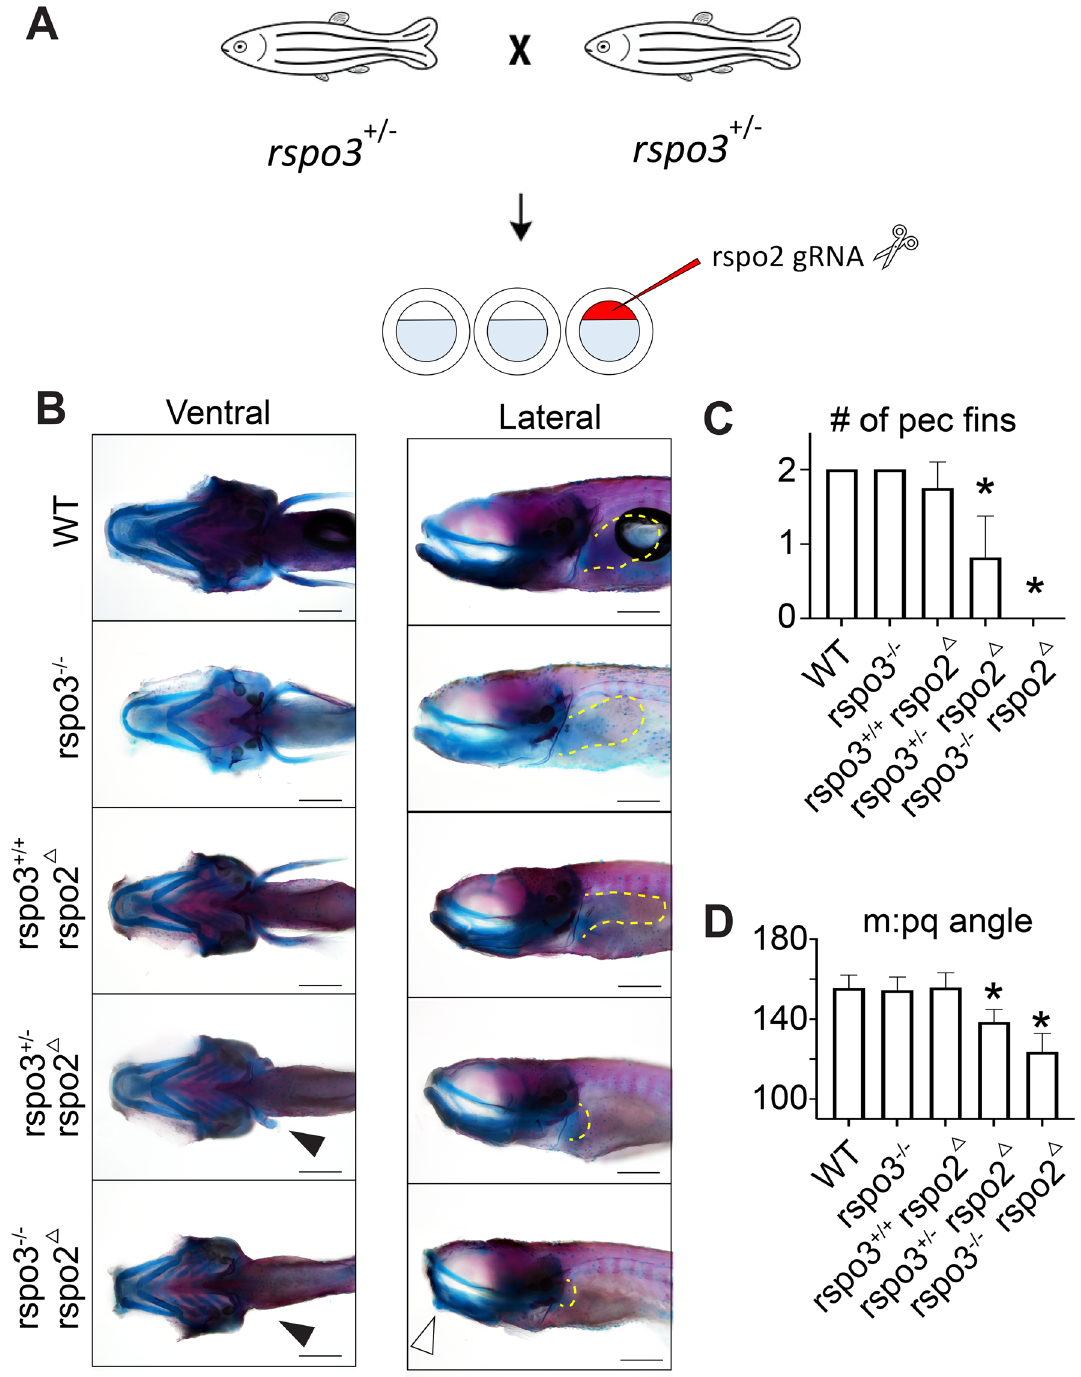
Figure 4. Synergistic effect of rspo2 and rspo3 ablation on zebrafish limb development and craniofacial morphology. ( A ) Schematic illustrating experimental design. Targeted mutagenesis of rspo3 −/− in zebrafish was carried out using CRISPR/Cas9 gene editing. A – 20 bp deletion was bred to homozygosity. Intercross or rspo3 +/− were injected with 4 gRNAs against rspo2 and the resulting larvae were genotyped and analyzed for phenotype. ( B ) Whole mount ventral and lateral images of Alcian blue/Alizarin red S stained 9 dpf larvae. rspo3 −/− embryos that were rspo2 gRNA/Cas9 injected ( rspo2 Δ ) larvae were similar to wild-type except that rspo2 Δ larvae exhibited disrupted development of the pectoral fin. Impaired fin development was exacerbated with decreasing genetic dosage of rspo3 (black arrows, dotted yellow lines delineate fins). While craniofacial development in rspo3 −/− and rspo2 Δ larvae were largely normal, rspo3 −/− ; rspo2 Δ double mutants exhibited a dysmorphic lower jaw (white arrow). Scale bar: 100 μm. ( C ) Quantification of pectoral fin developmental disruption. rspo2 Δ larvae tended to have disrupted development of a single pectoral fin. This effect was significantly exacerbated with decreasing genetic dosage of rspo3 , as rspo3 −/− ; rspo2 Δ double mutant larvae failed to develop pectoral fins altogether. ( D ) Quantification of angle measurements between Meckel’s cartilage (m) and palatoquadrate (pq). While rspo3 −/− and rspo2 Δ mutants had normal lower jaw morphology, rspo3 +/− ; rspo2 Δ and rspo3 −/− ; rspo2 Δ mutants displayed a significantly decreased angle at the Meckel’s/palatoquadrate joint. N = 10–16. p < 0.01. *Indicates significance relative to